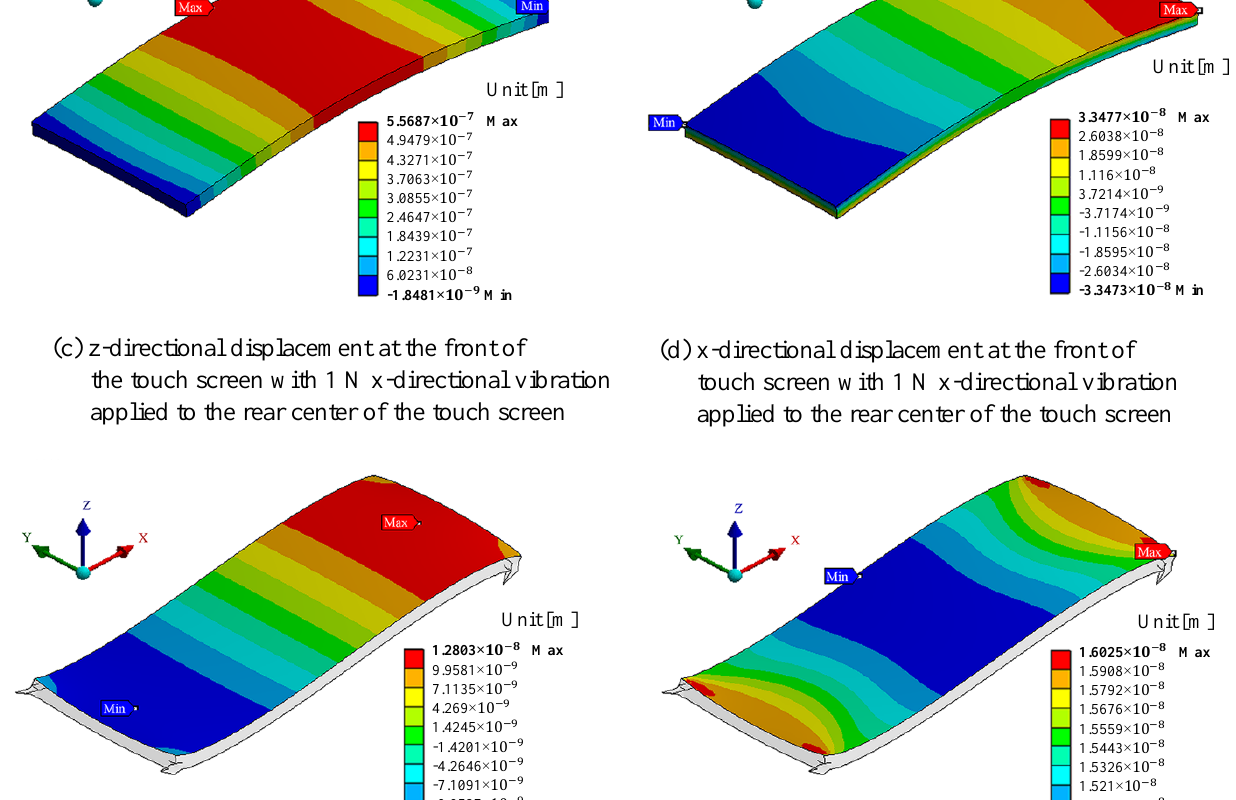
FIGURE 9. Vibrational displacement on the surface of the touch screen according to the vibration direction of the actuator.